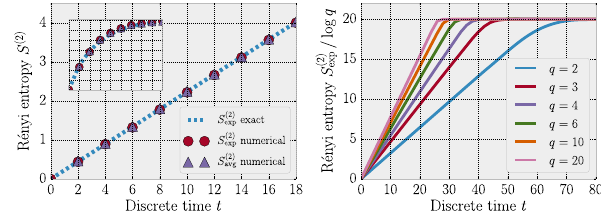
FIG. 5. Entanglement growth in the random circuit model. Left panel: Comparing the exact formula, Eq. (25), to matrix product 2 Þ − log e − S ð 2 Þ and state numerics shows that it captures both S ð exp ¼ 2 Þ ð 2 Þ of the second R´enyi entropy. The main the average S ð avg ¼ S 50 sites, while the figure shows the time dependence for L A ¼ 2 . Right panel: The entanglement velocity inset is for L A ¼ increases with q according to Eq. (27), while the saturation regime becomes